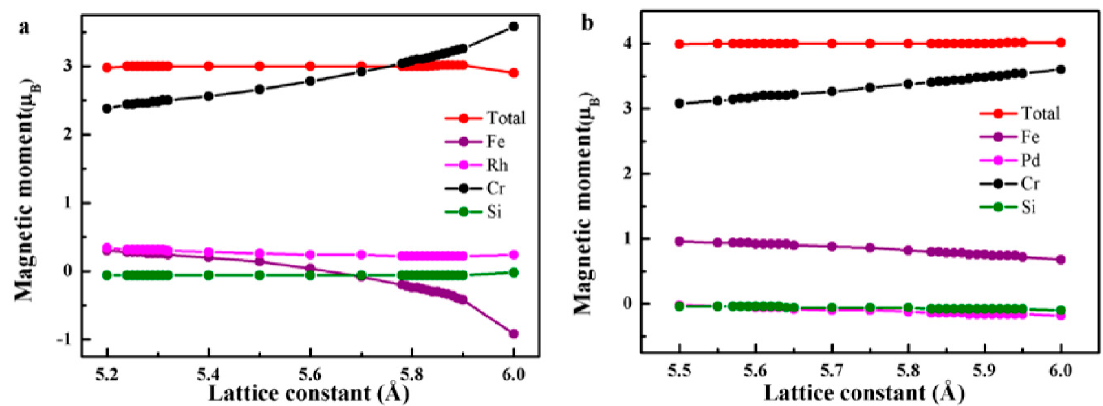
Figure 9. The total and partial magnetic moments as functions of lattice constants for ( a ) FeRhCrSi and ( b ) FePdCrSi.